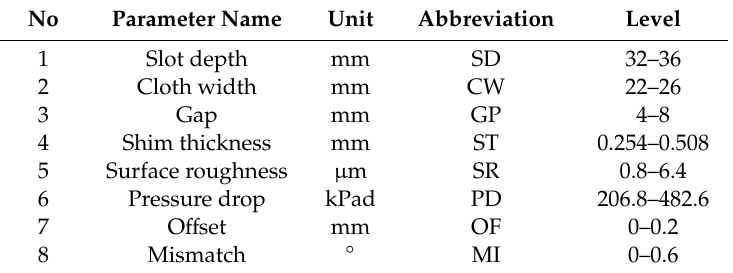
Table 2. Parameters of screening experiments with levels.